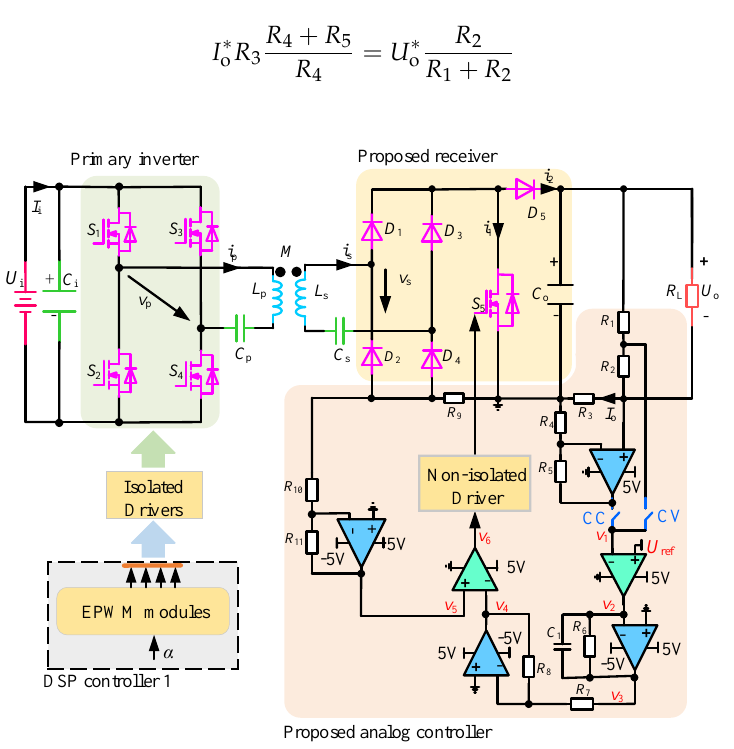
Figure 6. Algorithm flowchart of DPC receiver.